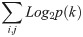
Information content of 1 bit sketches.Upper panel: distributions of the information content of the 1 bit color (orange) and luminance (gray) sketches. Information of a single sketch, S(i, j), is calculated as ∑i,jLog2p(k), where k (i,j) is the pattern matching the patch centered at pixel (i,j), summed over all the image. The distributions are taken over the entire image database of our study. Lower panel: percentage of correct discrimination, averaged over all subjects, plotted as a function of the information content of the color only (orange) and luminance (gray) sketches, for the same data as in Fig 3. Error bars are SEM. The dashed line represents chance level.